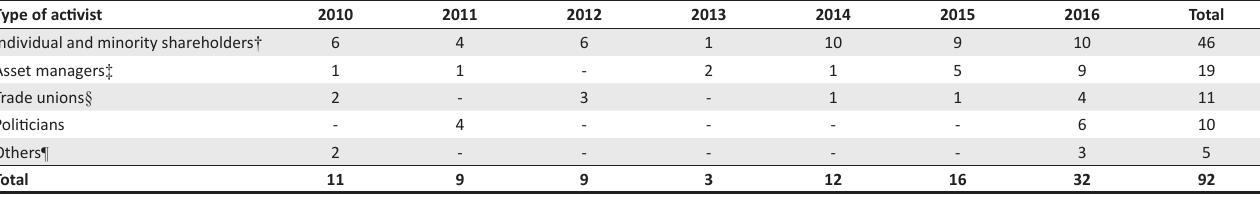
TABLE 1: Number of ‘say on pay’ events based on activist type. Type of